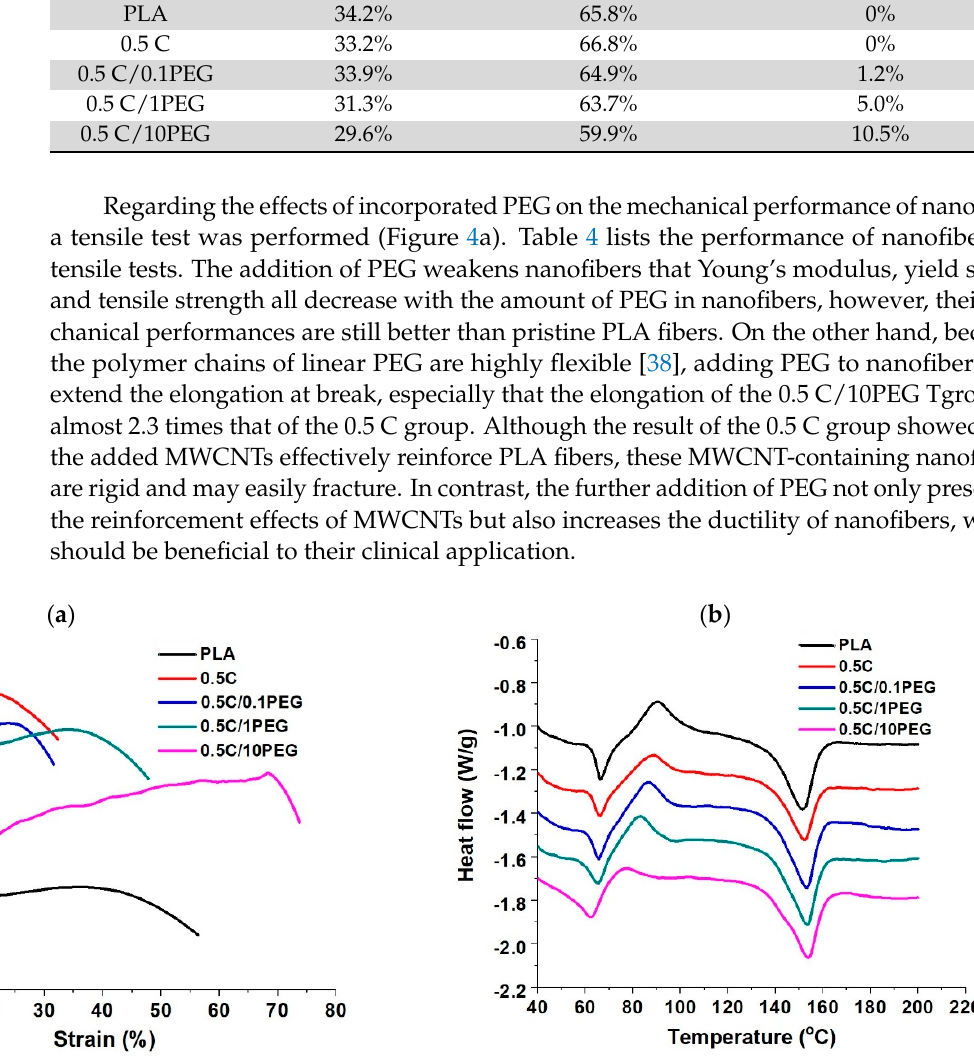
Figure 4. Characteristics of PEG-containing nanofibers by ( a ) tensile test and ( b ) DSC analysis.